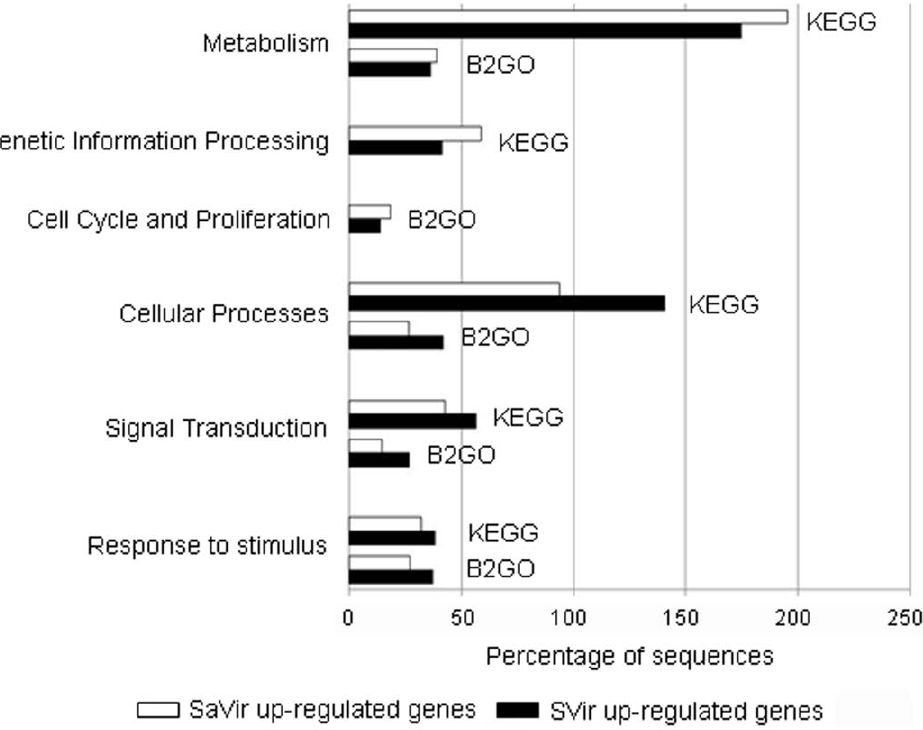
Figure 3. Functional annotation of unique ESTs differentially represented between SVir and SaVir libraries, respectively. Categorization was based on KO terms of the Kyoto Encyclopedia of Genes and Genomes (KEGG) using KEGG Automatic Annotation Server (KAAS), and on GO terms of Biological Process using Blast2GO software.